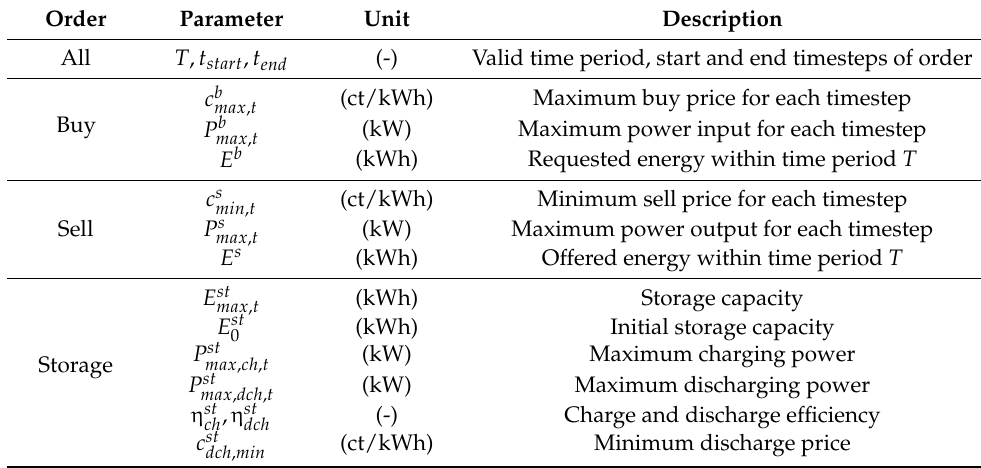
Table 2. Overview of parameters for market orders.